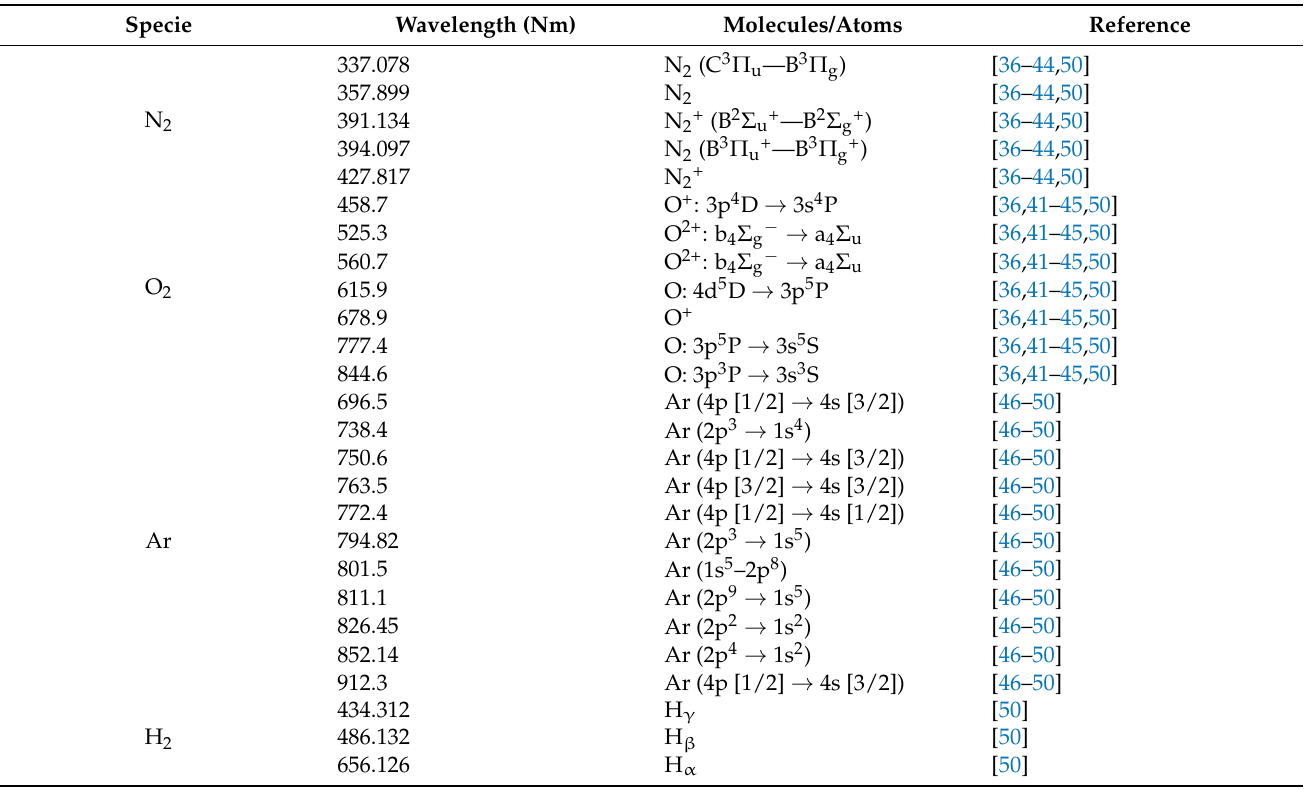
Table A1. Major OES peaks for N, O, Ar, and